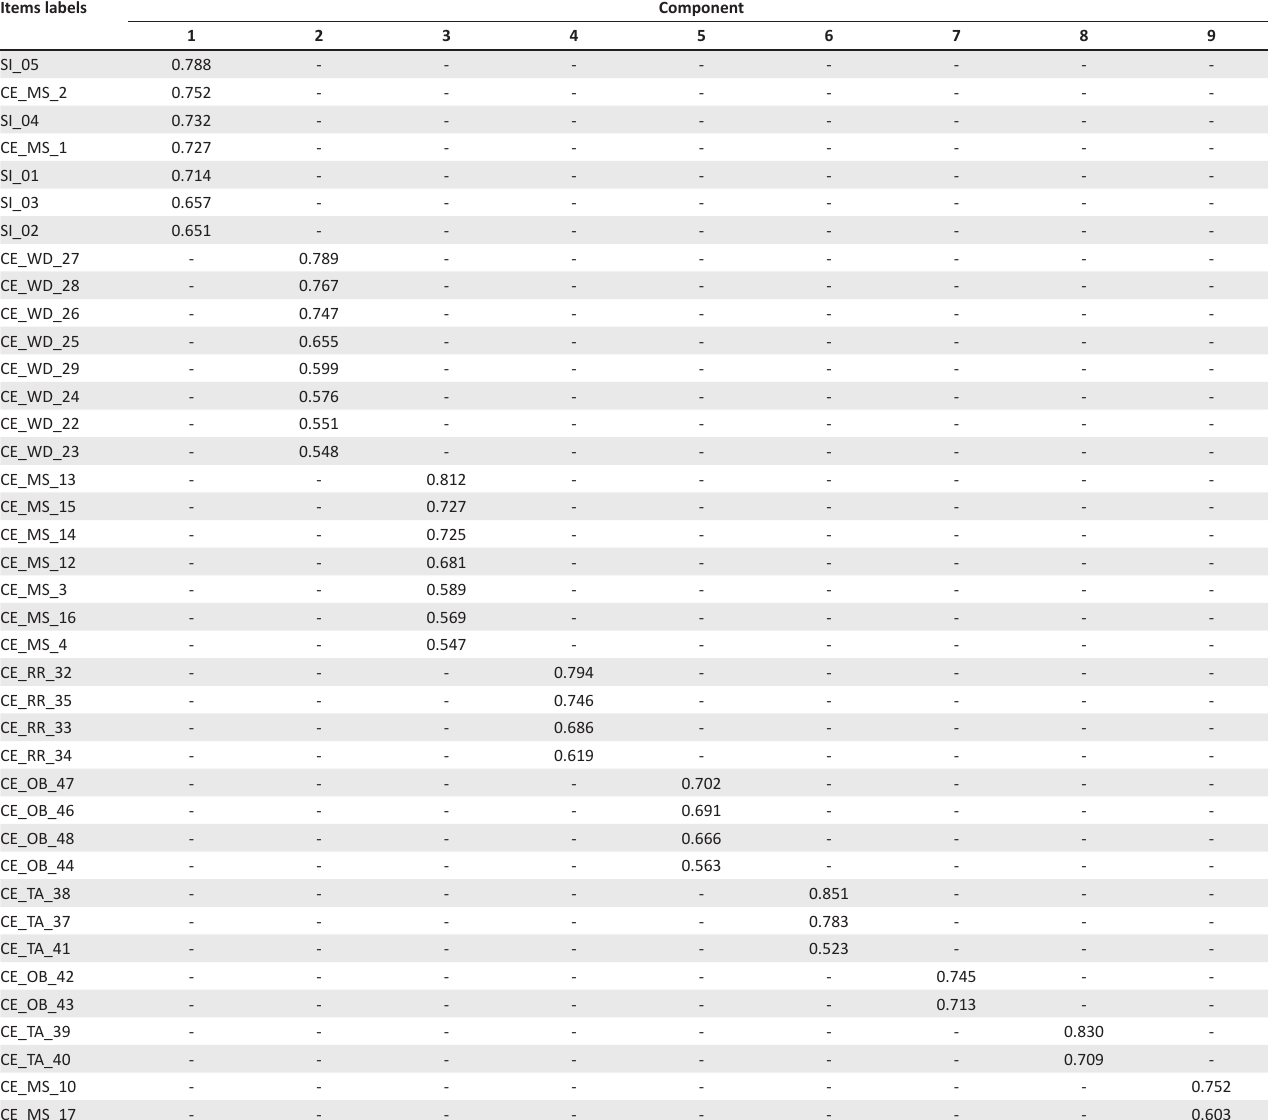
TABLE 2: Rotated factor